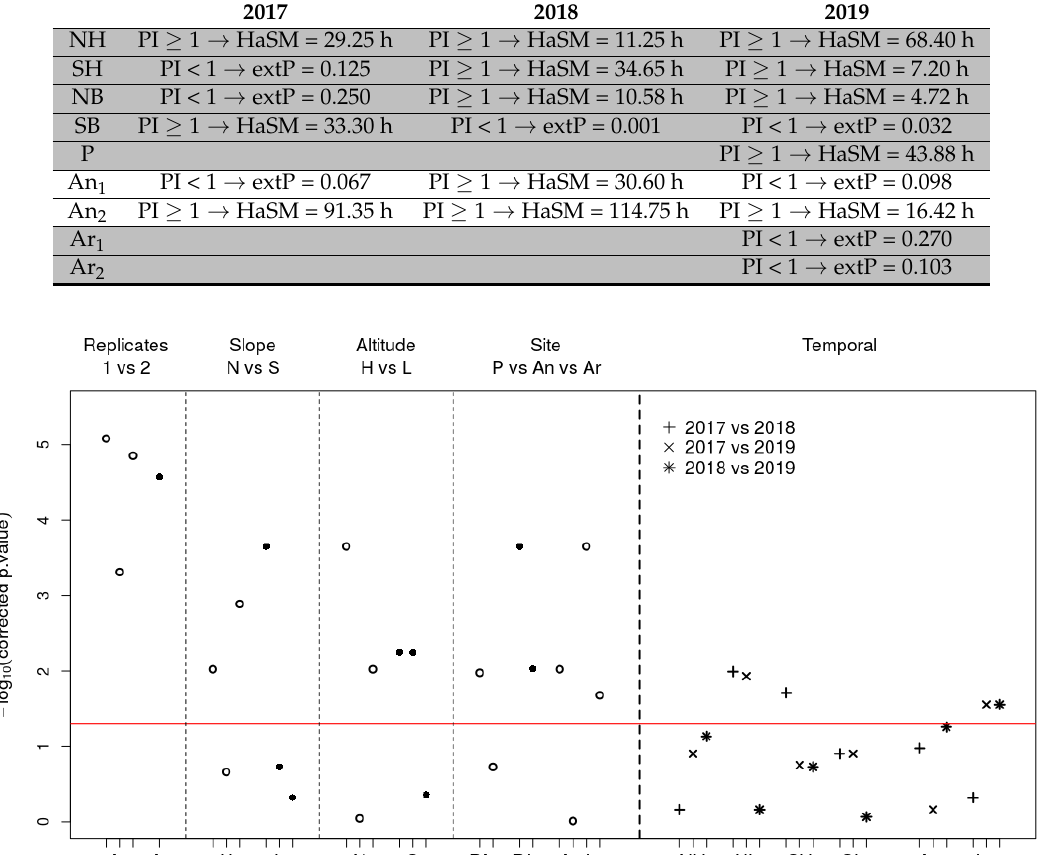
Figure 3. p -values of the 42 Wilcoxon Sign Ranked tests for paired samples, corrected with the false discovery rate method (FDR). The spatial variability (circles) is studied on the left side of the graph and the temporal variability (cross) on the right side. Concerning the intra-site variability (part Replicates) and the inter-slope and inter-altitude variabilities (parts Slope and Altitude), the three grouped graduations correspond to the analysis of the data from 2017 then 2018 then 2019. For the inter-site comparisons (part Site), the graduations permit to distinguish the two replicates from the Anglas and Arrious sites. The comparison order is the same as in Tables 1 and